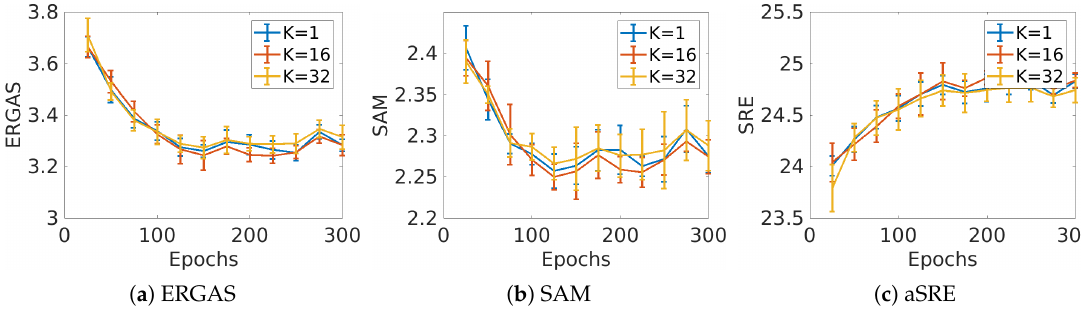
Figure 8. Values of the quality evaluation metrics as a function of the number of Epochs for the Rvk-A dataset and for K = 1, K = 16, and K =